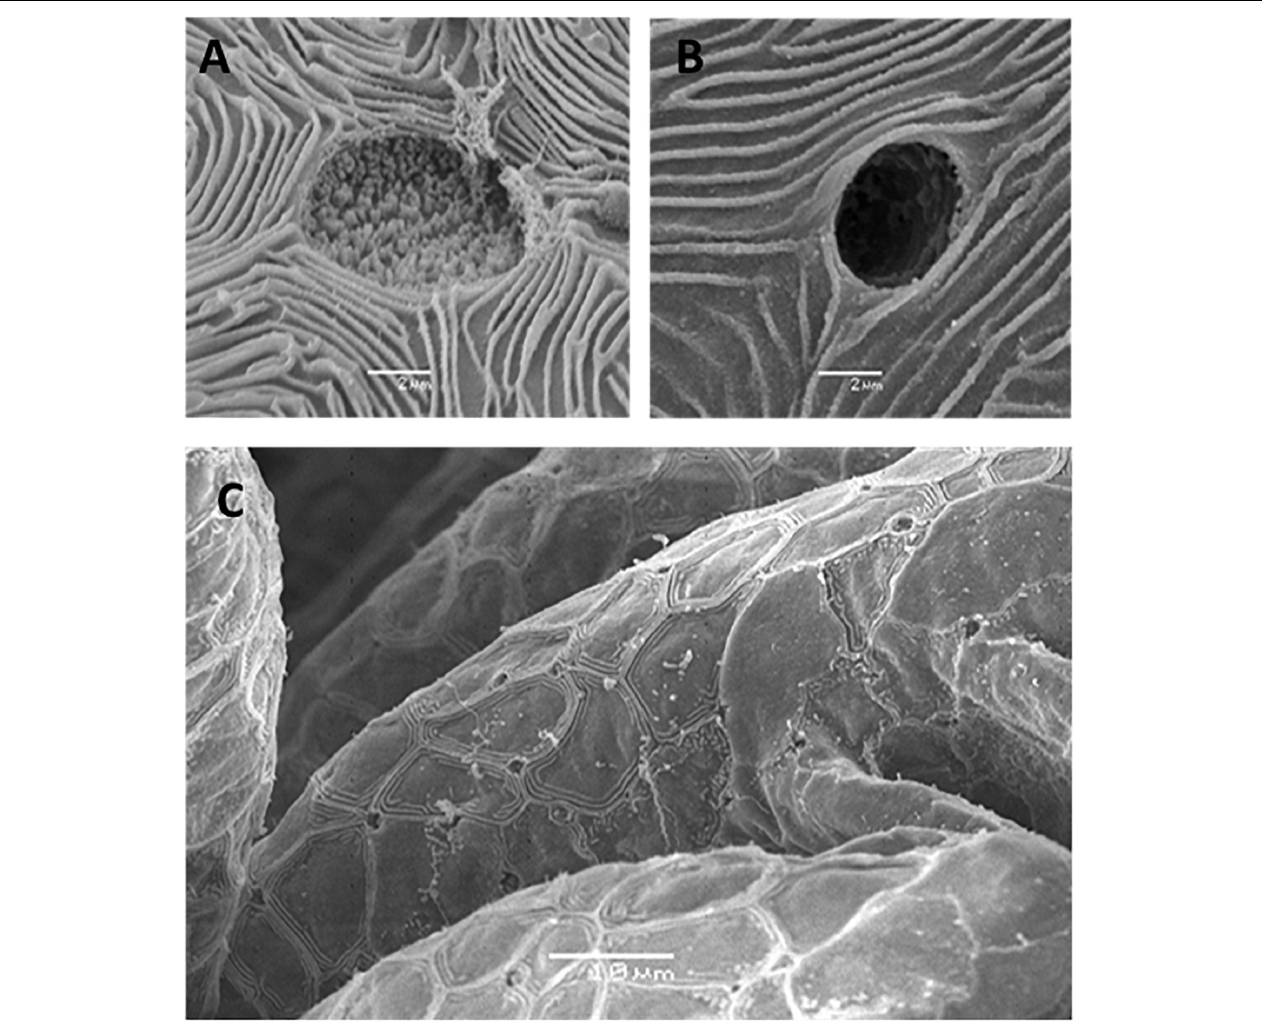
FIGURE 3 | Scanning electron micrographs of external morphology of ionocytes during early life stages. (A) Apical opening of an ionocytes on yolk-sac epithelia of Nile tilapia in freshwater adapted larvae at hatch (Bar = 2 µ m), (B) Apical opening of an ionocyte on yolk-sac epithelia of Nile tilapia in brackish water adapted larvae at hatch (Bar = 2 µ m) and (C) Lower magnification of apical openings of an ionocyte on gill filaments of freshwater larvae at 3 dph (Bar = 10 µ m) [from Fridman et al. (2011)].